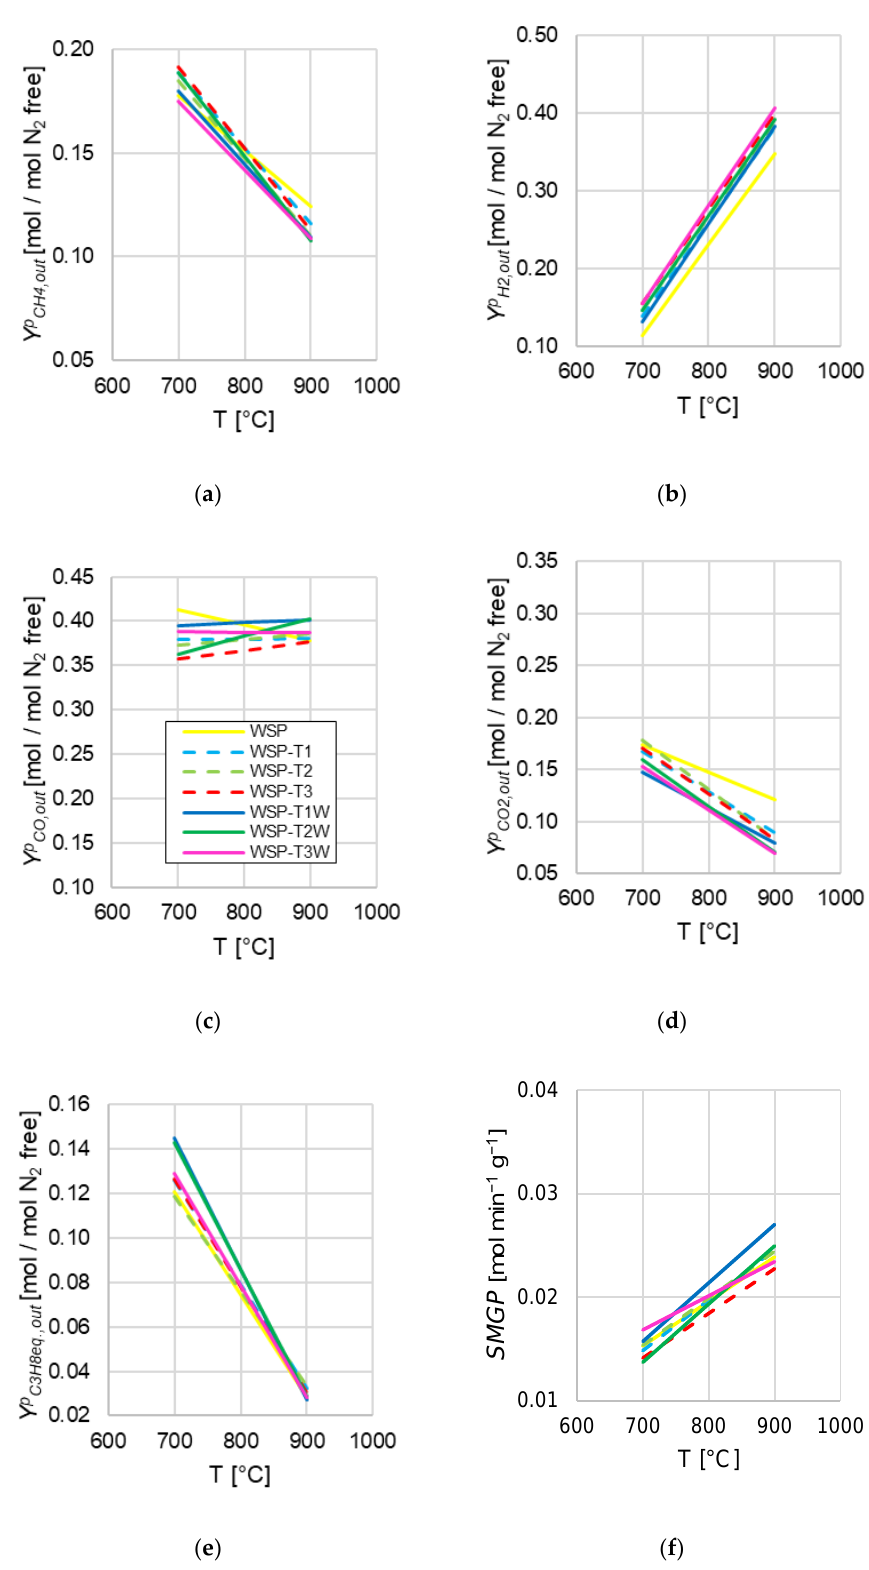
Figure 6. Regression lines obtained from data at the top of devolatilization peaks, compared for investigated biomasses: ( a ) Y p (Equation (5)); ( b ) Y p (Equation (5)); ( c ) Y p (Equation (5)); ( d ) Y p (Equation (5)); H 2 , out CH 4 , out CO , out CO 2 , out ( e ) Y p (Equation (5)); ( f ) SMGP (Equation (6)); the legend in ( c ) is valid for the entire C 3 H 8 eq ., out